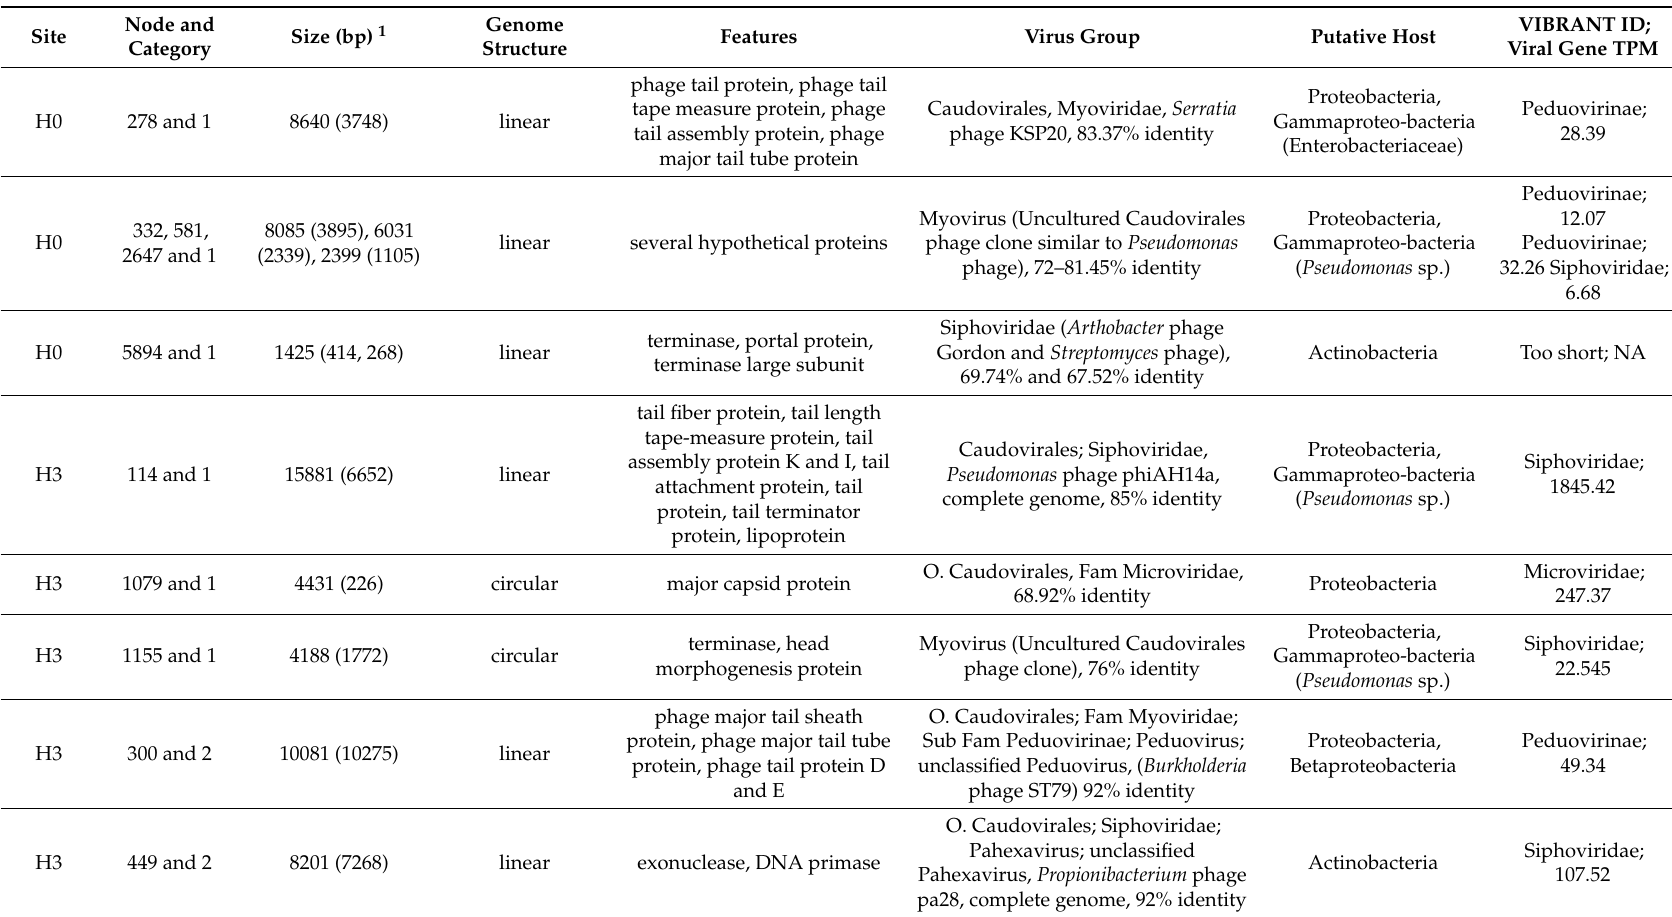
Table 3. Viral genome composition and structure diversity in according to Virsorter and